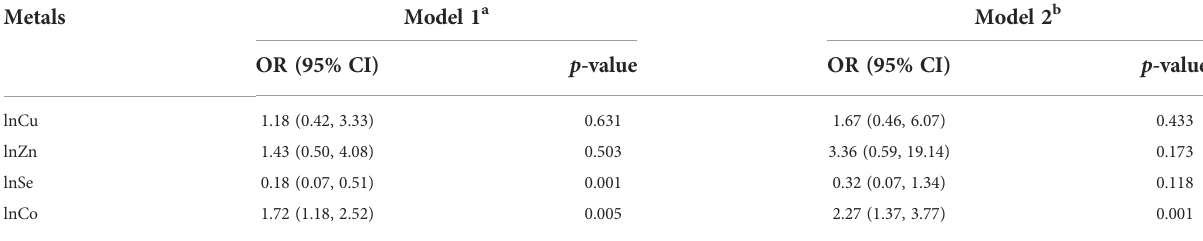
TABLE 2 OR [95% (CI)] for the associations of early embryonic arrest with concentrations of blood essential trace elements (Cu, Zn, Se,